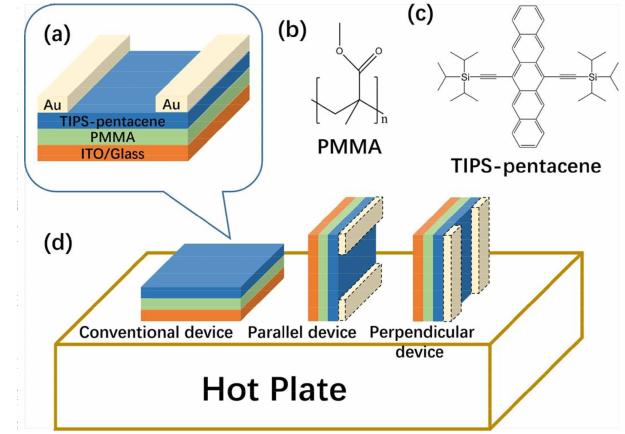
Figure 1. Device architecture of the OTFTs used in this study ( a ). Molecular structures of PMMA ( b ) and TIPS-pentacene ( c ). Schematic of OTFT subjected to different annealing processes ( d